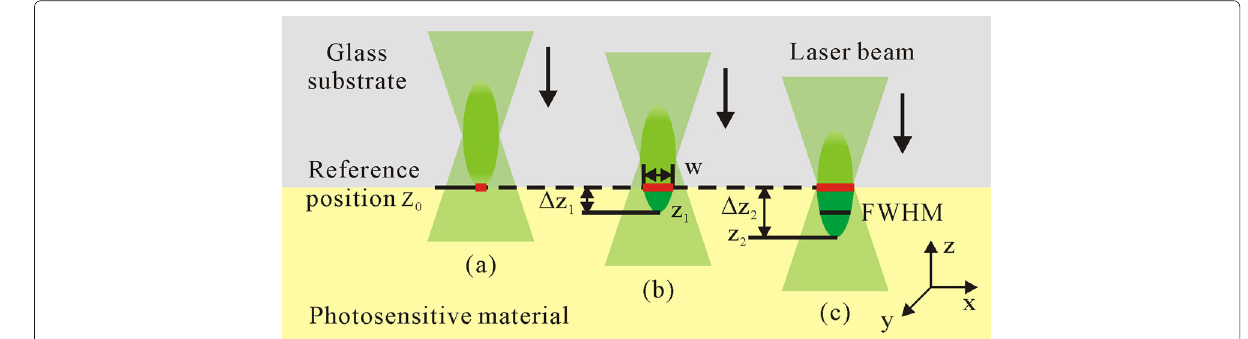
Fig. 5 Illustration of the variation of laser focus position along z